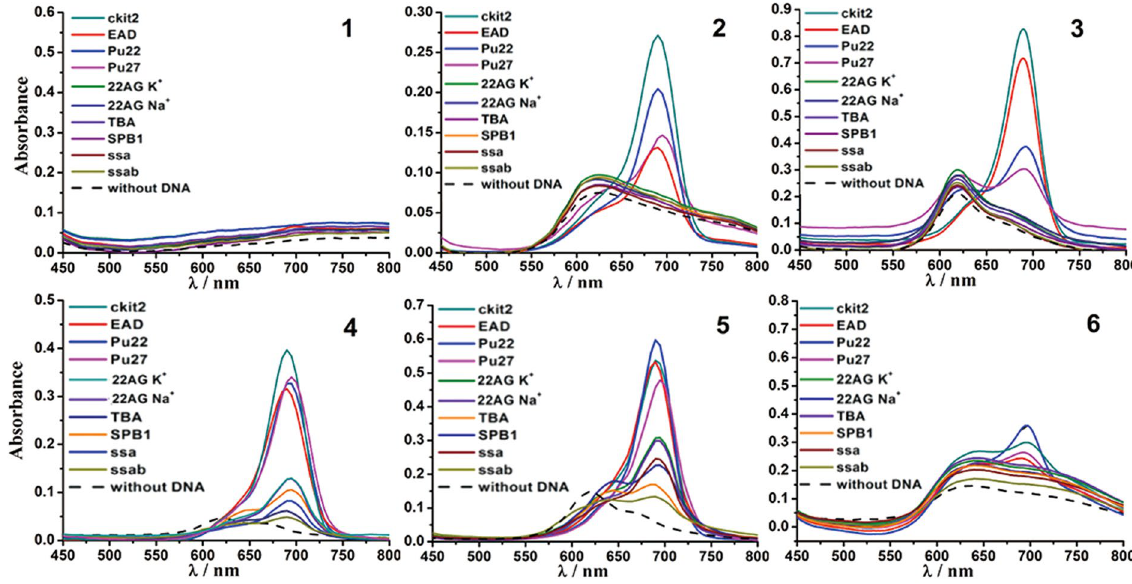
Figure 3. Absorption spectra of 1 – 6 (10 μ M) with different DNA sequences (30 μ M) in Tris-HCl buffer.